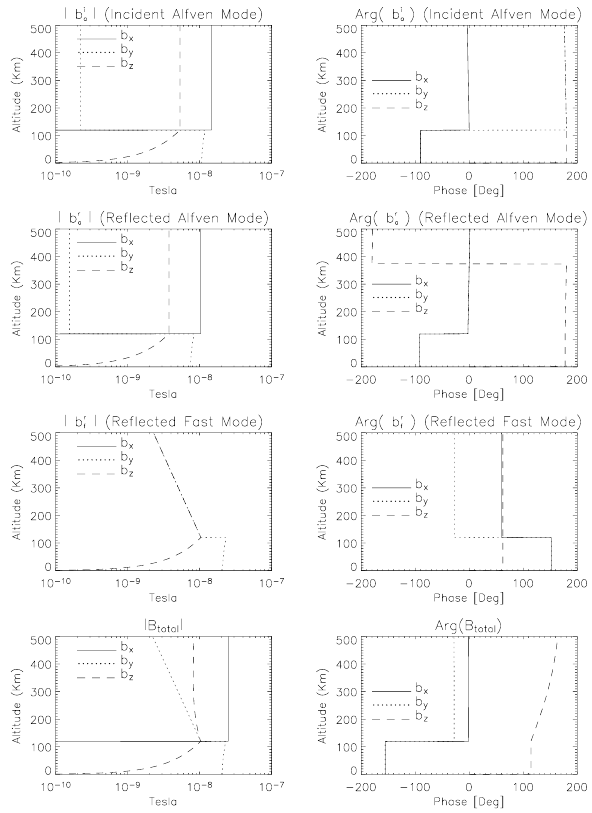
Fig. 8. Separation of the ULF magnetic wave fields using the analytical model of Sciffer et al. (2004). The parameters are the same as Fig. 7 but with k y = 4 × 10 − 6 m − 1 . Left-hand-panels show the magnitude of the respective wave fields while the right-hand- panels show the